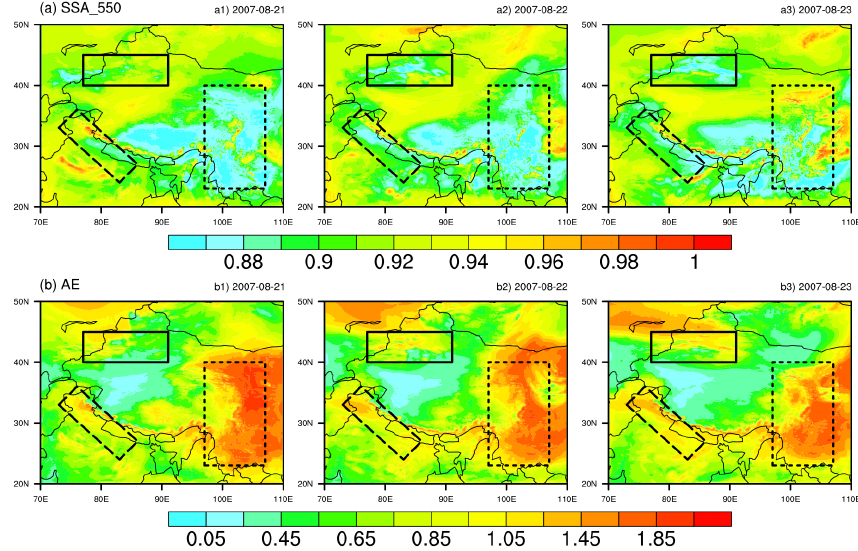
Figure 4. Simulated daily mean distributions of the (a) single scattering albedo and (b) Ångström exponent from 21 to 23 August 2007. The black rectangles indicate three areas of interest.